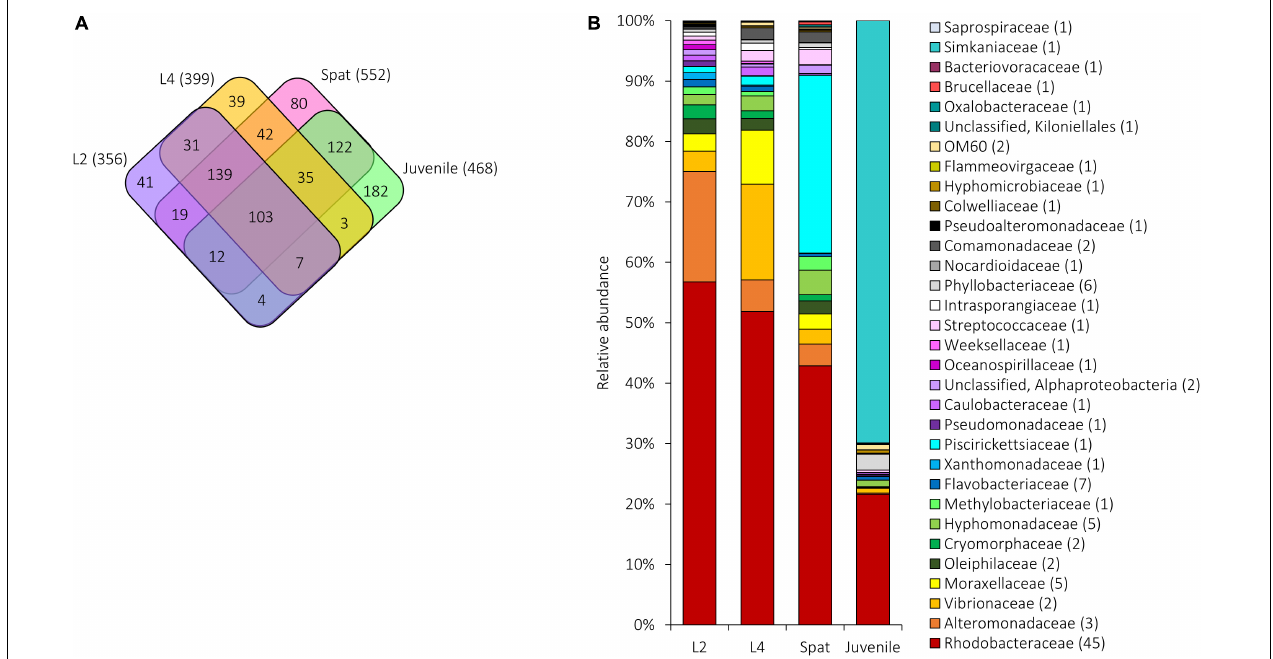
FIGURE 6 | Shared and unique microbial communities associated with A. digitifera early life stages: L2, 2-day-old larvae; L4, 4-day-old larvae; Spat, newly settled spat; Juvenile, 6-month-old juveniles. (A) The number of OTUs unique to or shared between the development phases. The total number of OTUs associated with each stage is in parentheses. (B) Relative abundance of the 109 bacterial OTUs shared among early life stages. Sequences were classified at family level where possible, with unclassified sequences indicated at higher taxonomic resolution. Numbers in parenthesis demark the number of different OTUs within the respective